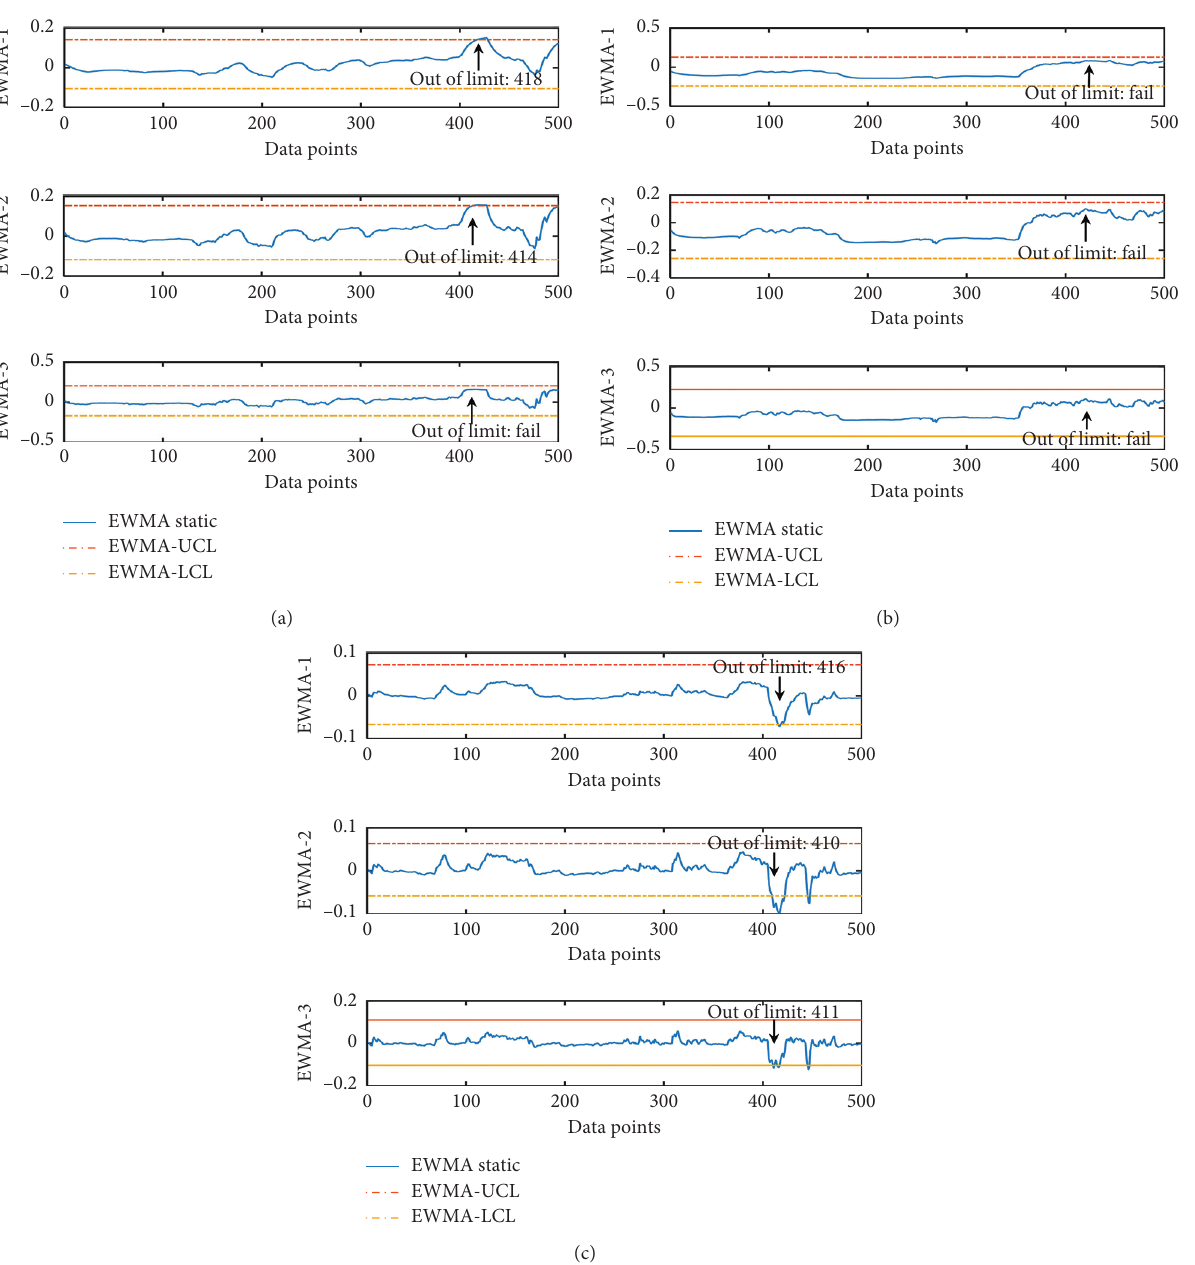
Figure 7: Residuals monitored by various EWMA control charts with (a) anomaly A, (b) anomaly B, and (c) anomaly